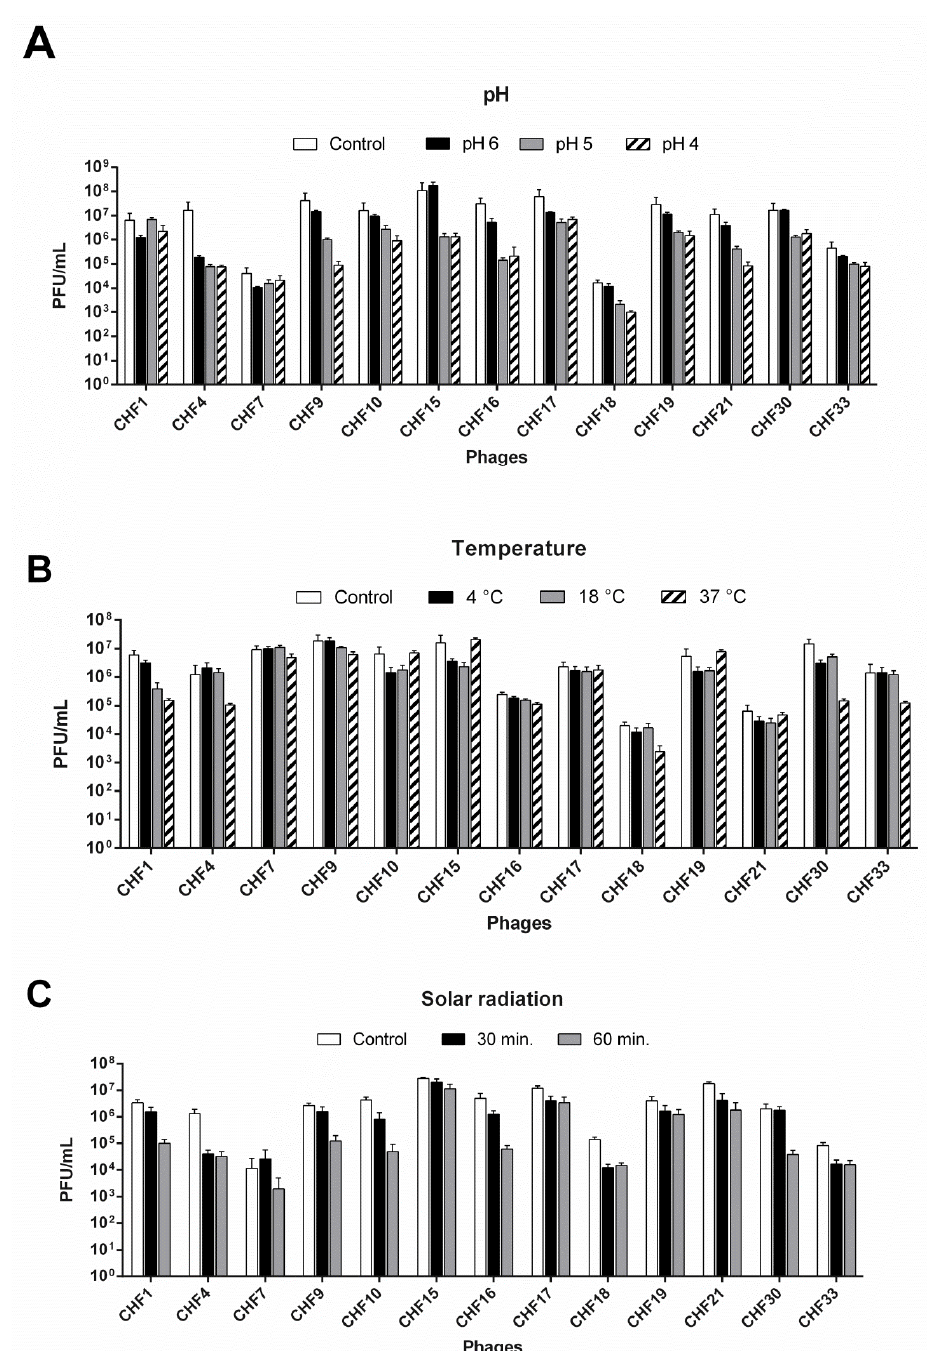
Figure 1. Survival of Chilean Pseudomonas syringae pv. actinidiae (Psa) phages under different environmental conditions. The fourteen phages were exposed to pH 4–6 for 1 h ( A ), temperatures of 4, 18, and 37 °C for 1 h ( B ) and solar radiation (UV level 8) for 30 or 60 min ( C ). The phage titer was determined in each case and compared with the control condition: Incubation in pH 7 at 25 °C for 1 h without exposition to solar radiation. Experiments were performed in biological triplicate and the standard deviation bars are shown .